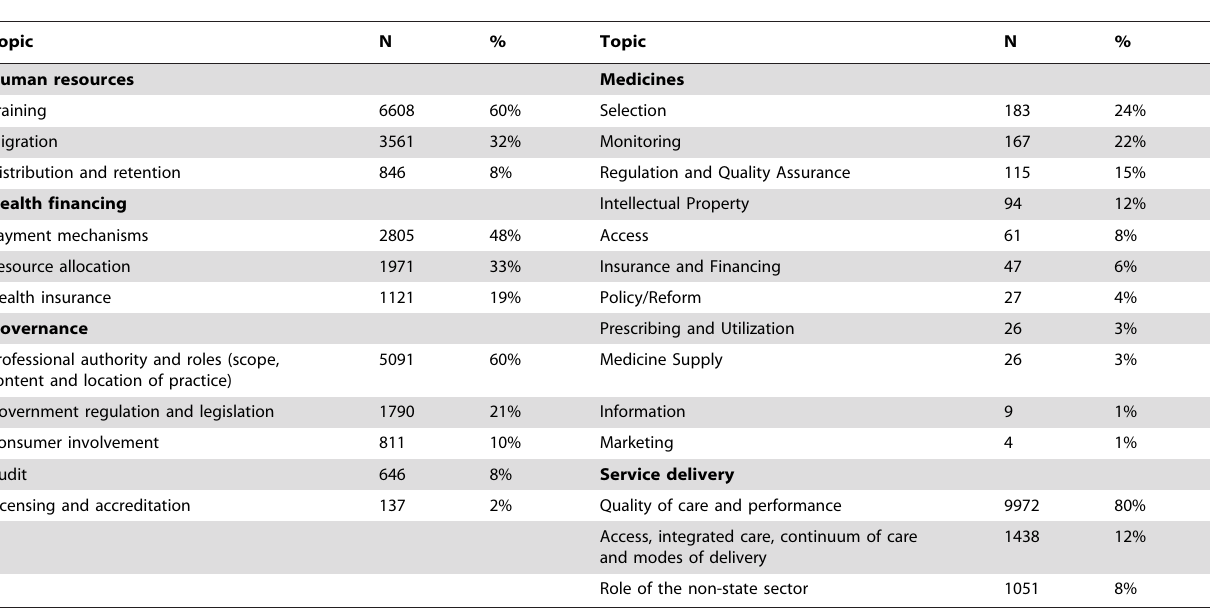
Table 3. Distribution of HPSR publications in LMICs by sub-topic (2003–2009) 1